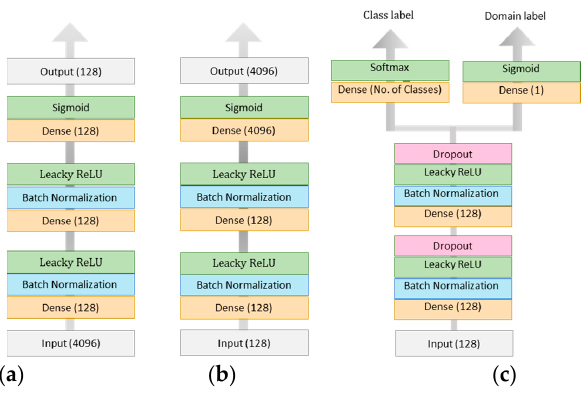
Figure 5. Architecture of the ( a ) encoder G, ( b ) decoder DE, ( c ) discriminator D, and classifier CL.